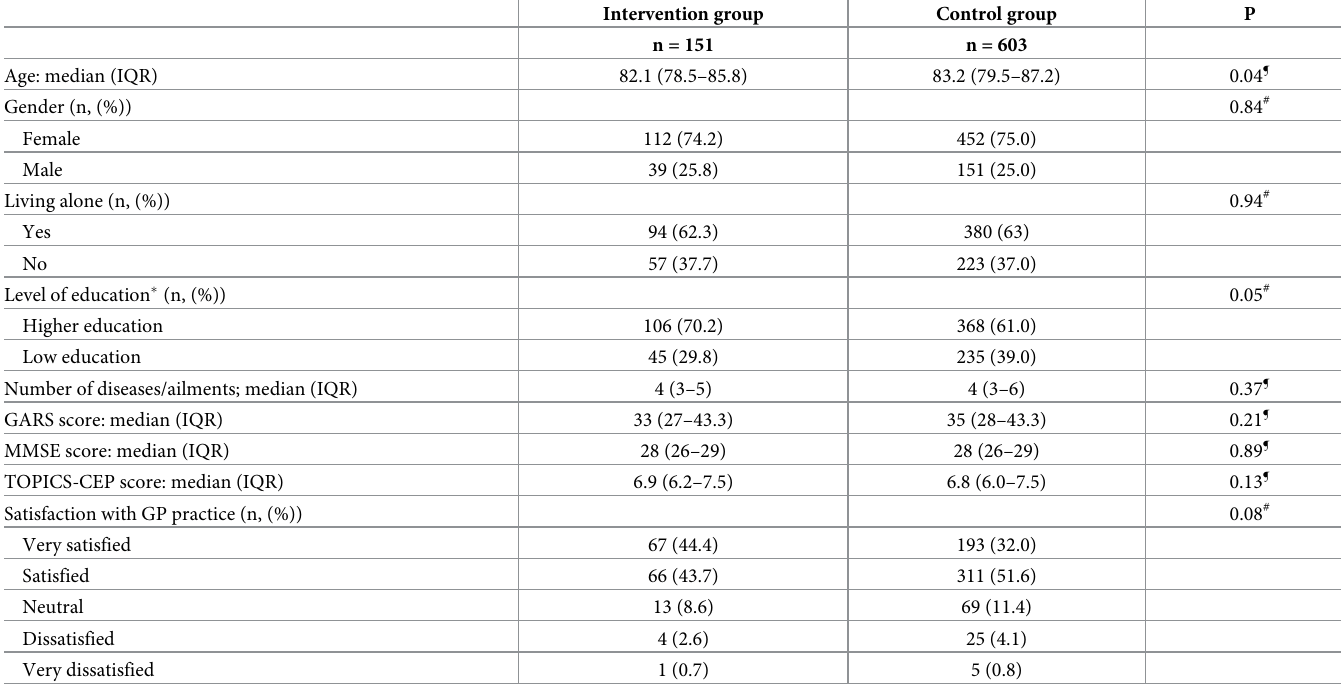
Table 1. Baseline sociodemographic, medical and functional characteristics, perceived health state and satisfaction of the participants for the intervention and con- trol group.